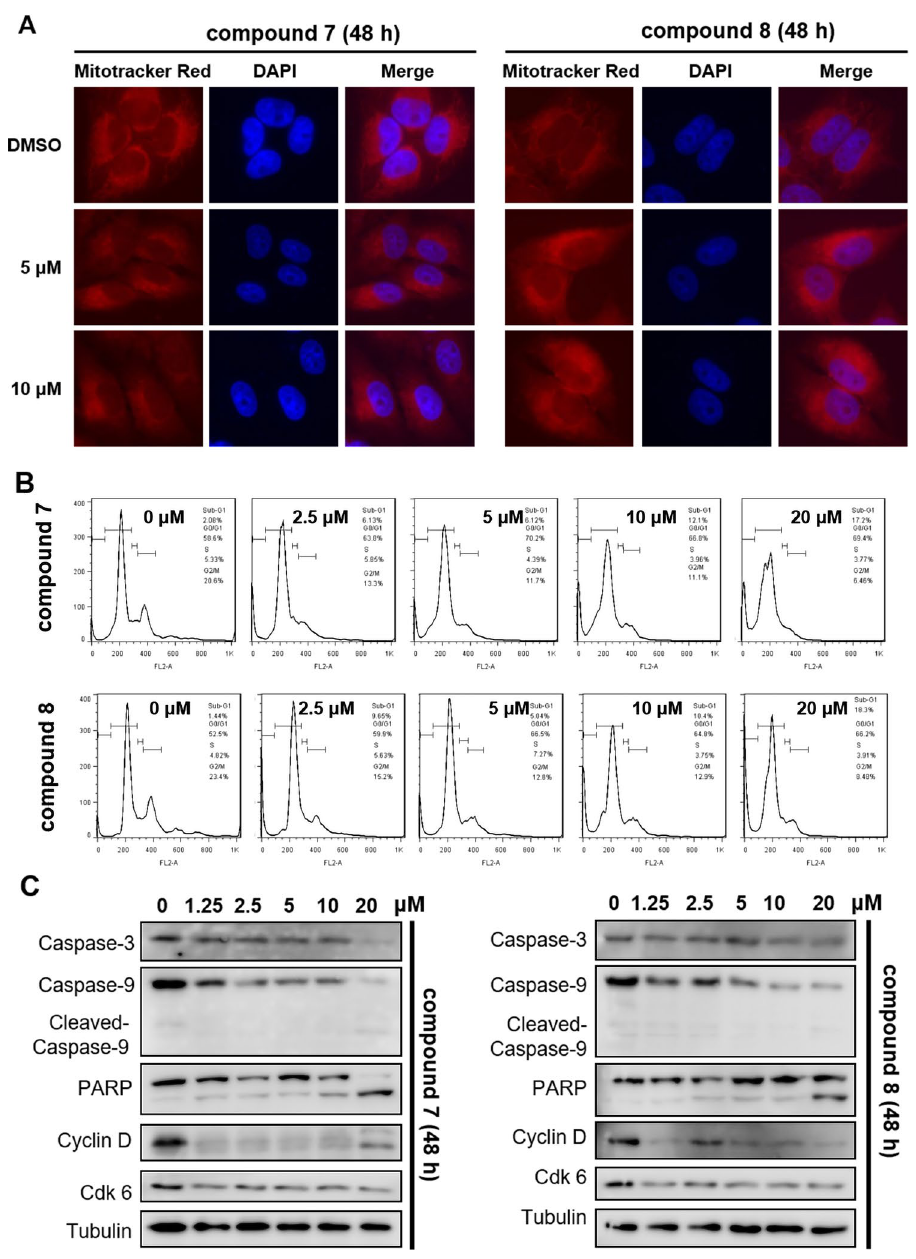
Fig. 6 Effects of compounds on apoptosis and cell cycle. a HeLa cells were stained with MitoTracker red (100 nM) and analyzed by fluorescence microscope. Scale bars: 10 μ M. b Cell cycle analysis in